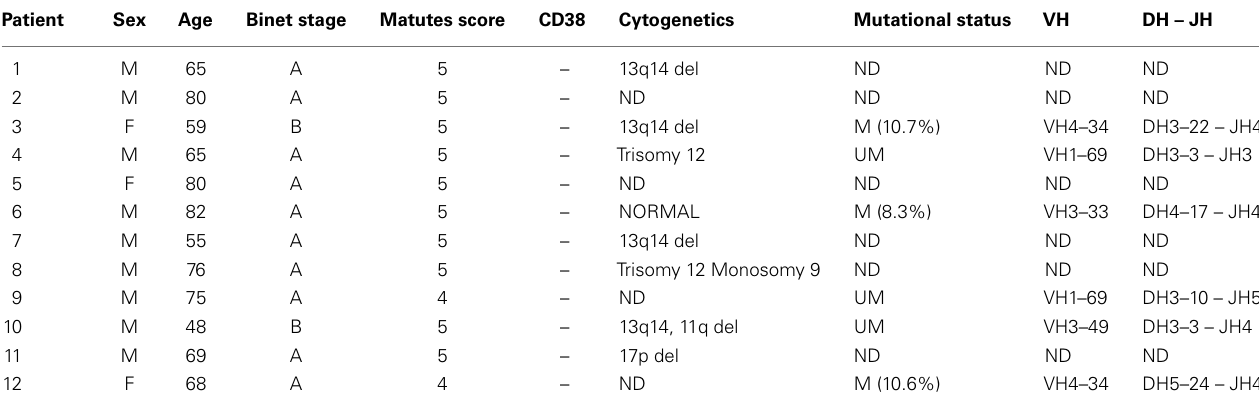
Table 1 | Patient characteristics andVDJH rearrangements